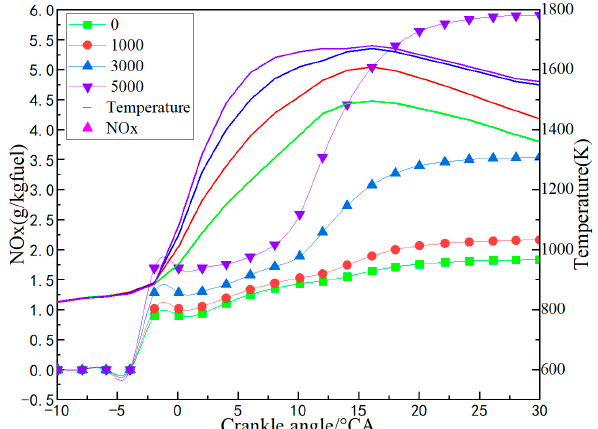
Figure 16. NOx emission at different altitudes.